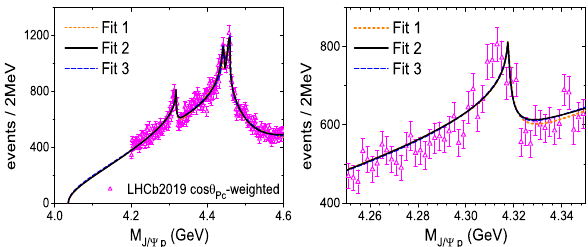
Fig. 1 Fits to the J /(cid:2) p spectroscopy of (cid:3) b → J /(cid:2) pK − . The right graph is enlarged around the P c ( 4312 ) . The LHCb 2019 data is the cos θ P -weighted one from Ref. [5] c